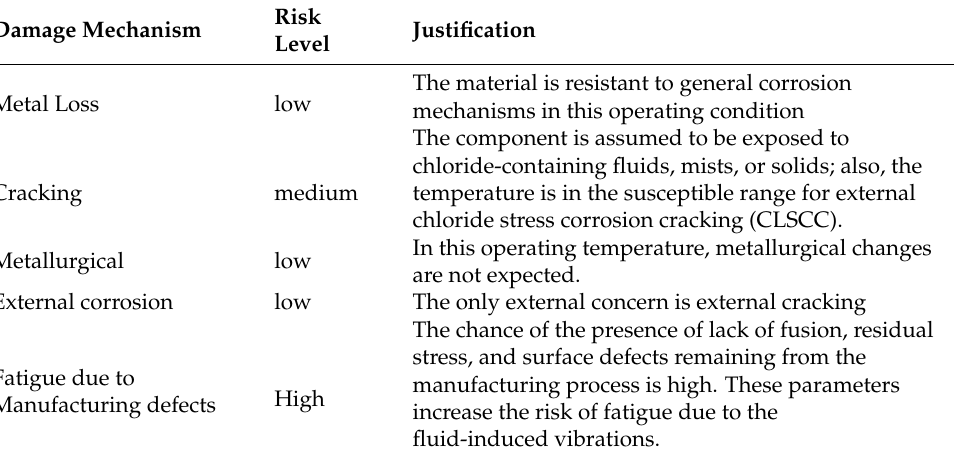
Table 8. Result of risk assessment for qualification of additively manufactured stainless steel nozzle